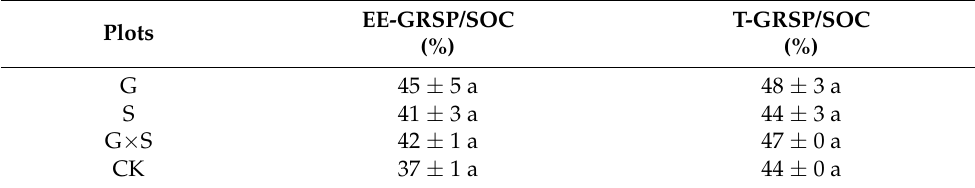
Table 2. Ratio of GRSP to SOC of rhizosphere soil among different vegetation types. Plots